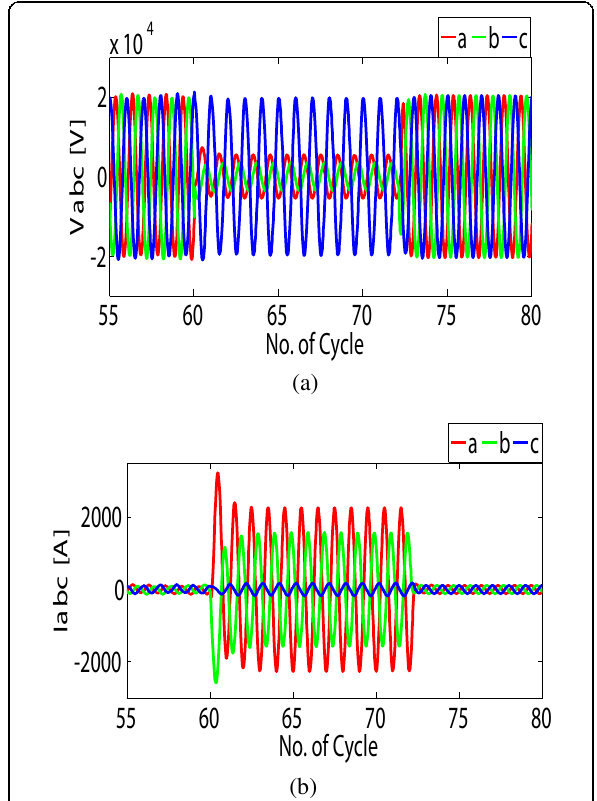
Fig. 8 Pre and Post Fault dynamic response of DG1. a Voltage at DG1 terminal after transformer. b Current at the DG1 terminal after